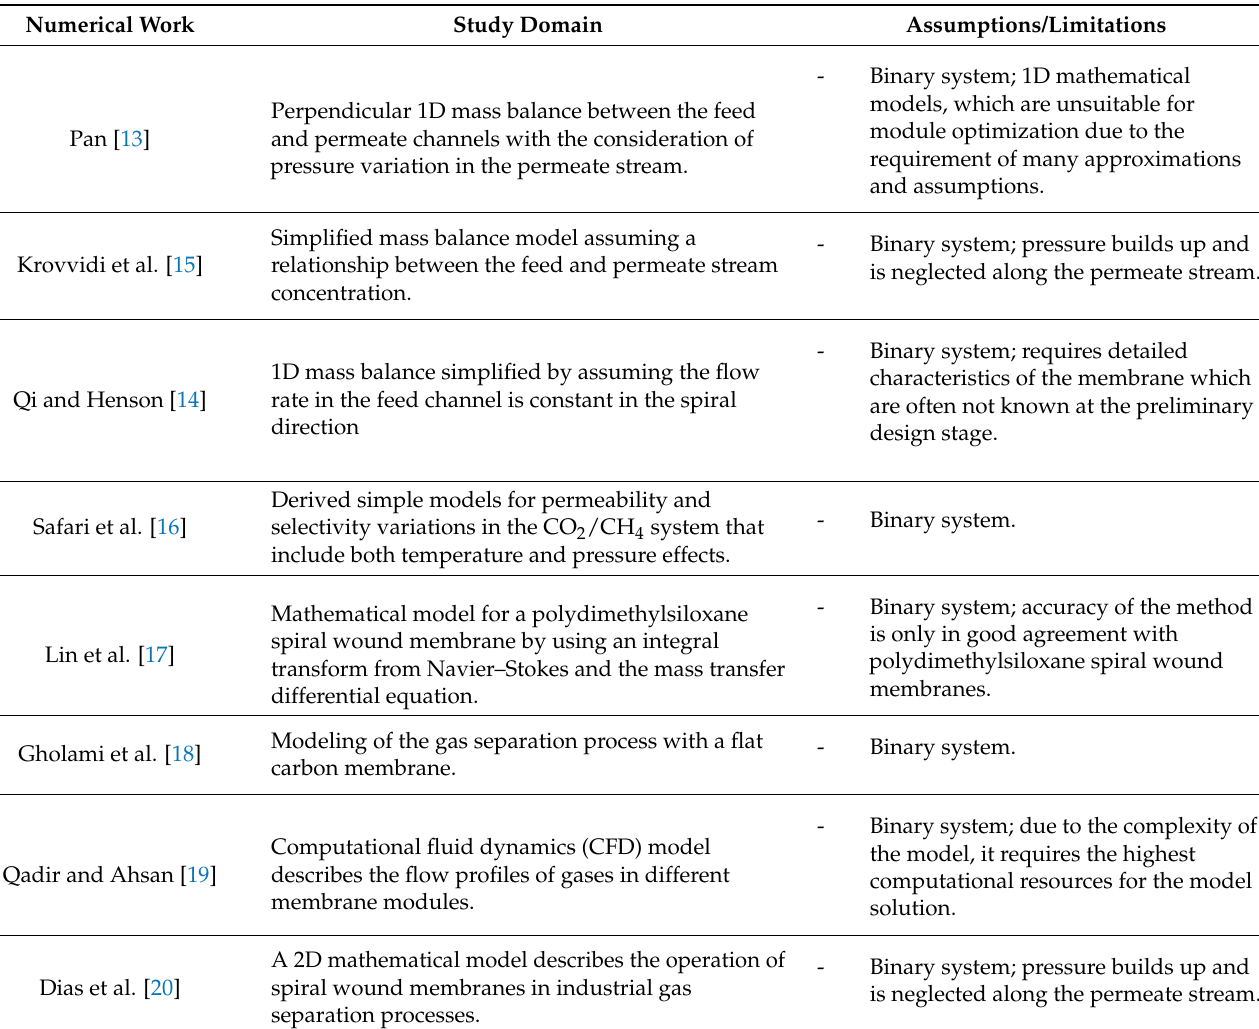
Table 3. Summary of major developments in methodology adapted to characterize the gas separation performance of SWM